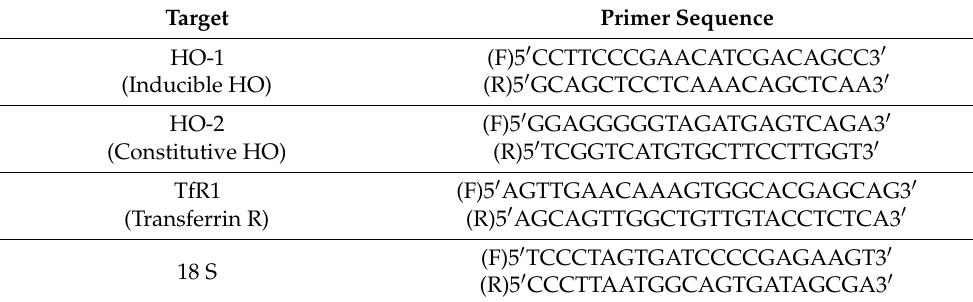
Table 1. Primers used for